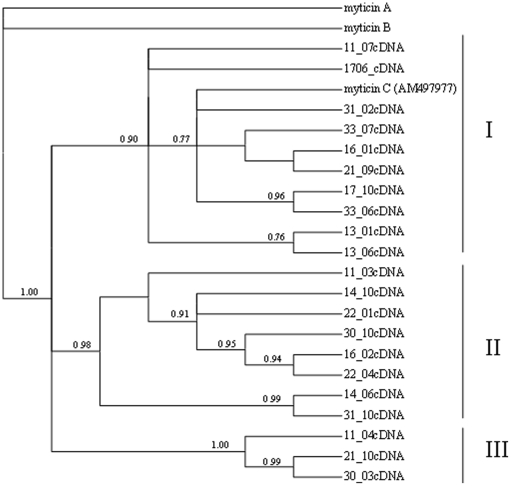
Bayesian tree of basic cDNA sequences of myticin-C.Values on branches indicate Bayesian posterior probability (only values >0.75 are showed). Tree was rooted using Myticin A (AF162334) and myticin B (AF1623354) sequences as outgroups.